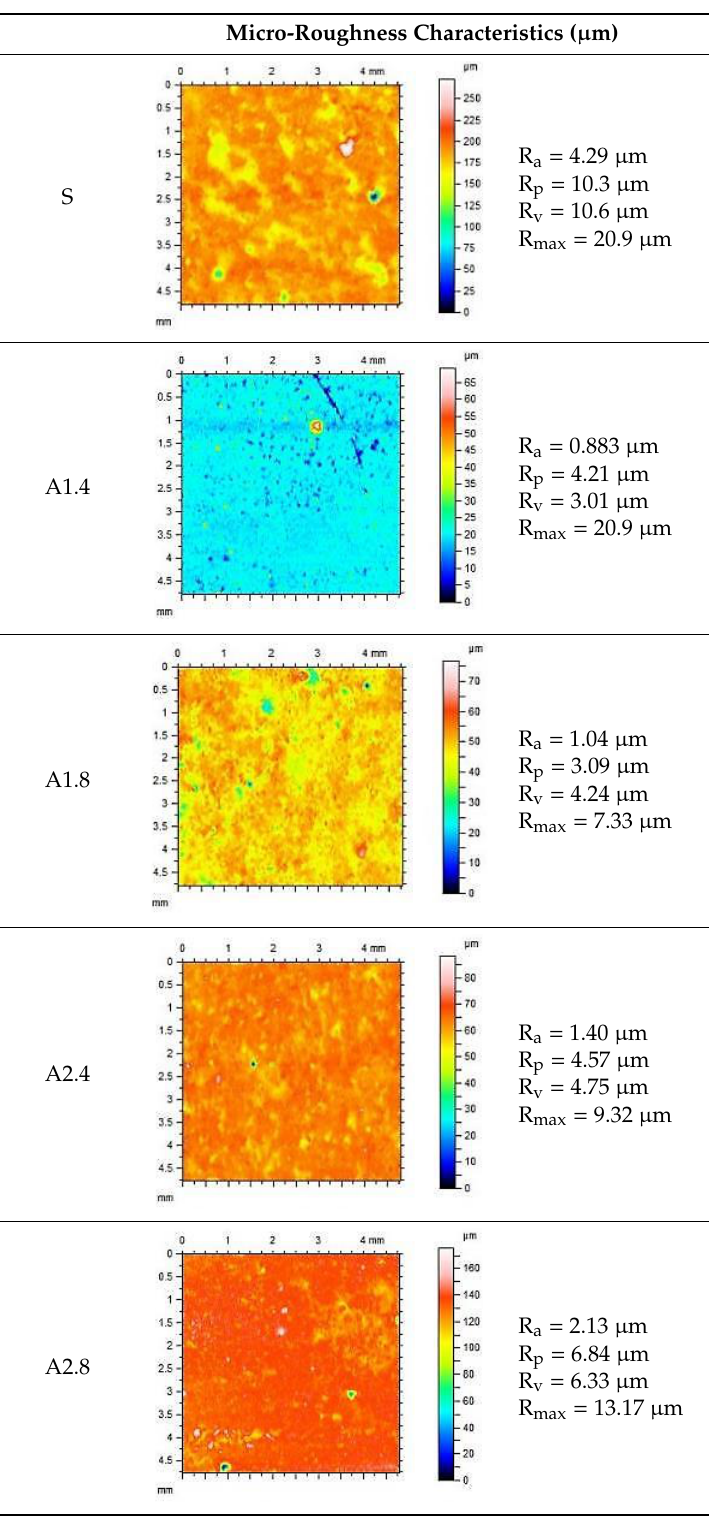
Table 8. Micro-roughness characteristics and image of the topography of mortars.